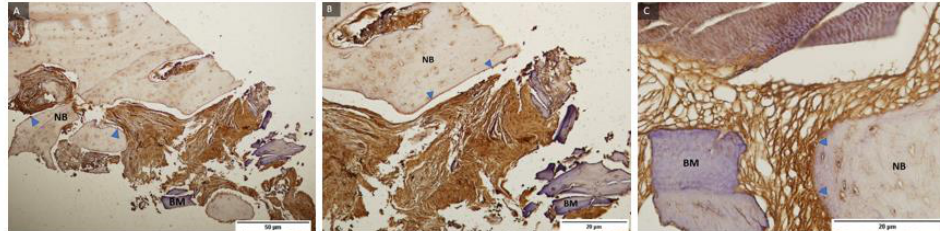
Figure 8. Examples of preparations of the test group ( A – C ) and BMP-2 immunohistochemical staining of bone sections after implantation of BMP-2 protein with labelling of newly formed bone (NB), residual biomaterial (BM), and cells with expression level 3 (+++) BMP-2 (triangle marked in blue). 100, 200, and 400× magnification .